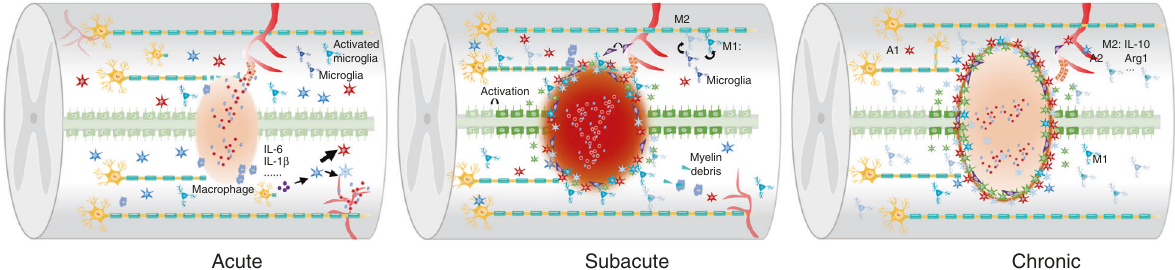
Fig. 3 Microglial and macrophage activation after SCI. This fi gure shows the changes in microglia and macrophages after SCI. In the acute phase of SCI, microglia are activated by cytokines and factors released from injured neural cells. Macrophages from blood vessels in fi